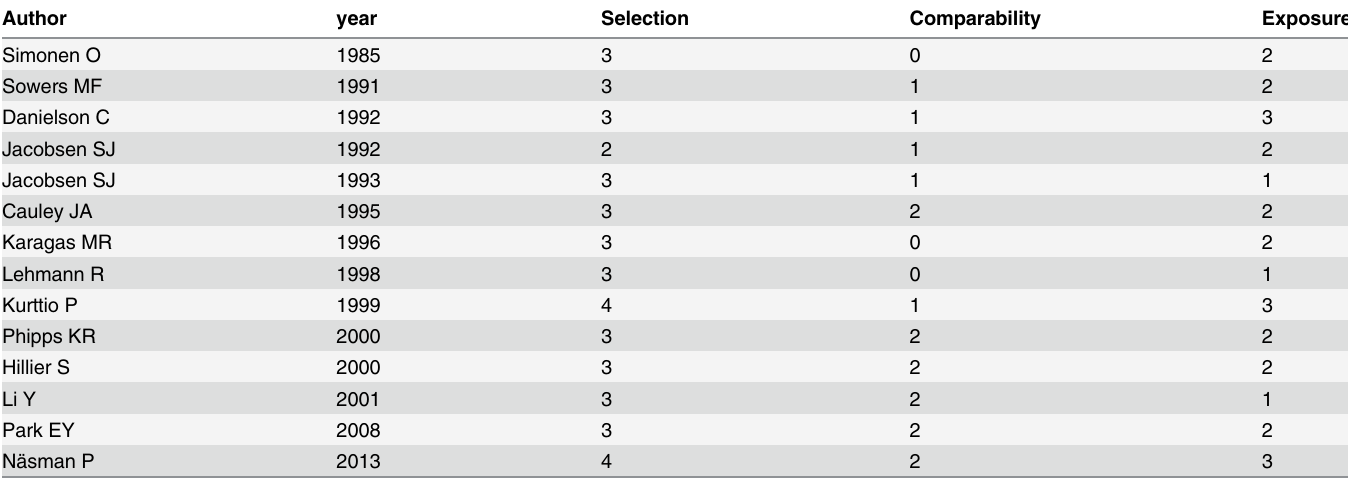
between exposure to water fluoridation and hip fracture risk was the primary outcome of inter- est for eight studies [5 – 7, 10, 13 – 15, 17], whereas this association was a secondary subject in six studies [4, 8, 9, 11, 12, 16]. Six studies did not adjust for confounding factors [7, 11 – 13, 16, 17], whereas the others controlled a group of conventional risk factors for hip fracture, such as age, gender, area, and smoking [4 – 6, 8 – 10, 14, 15]. The quality of the included studies was assessed by NOS (Table 3). The median NOS score was 6.5 (range: 4 to 9). Table 3. Quality assessment of included studies based on Newcastle-Ottawa